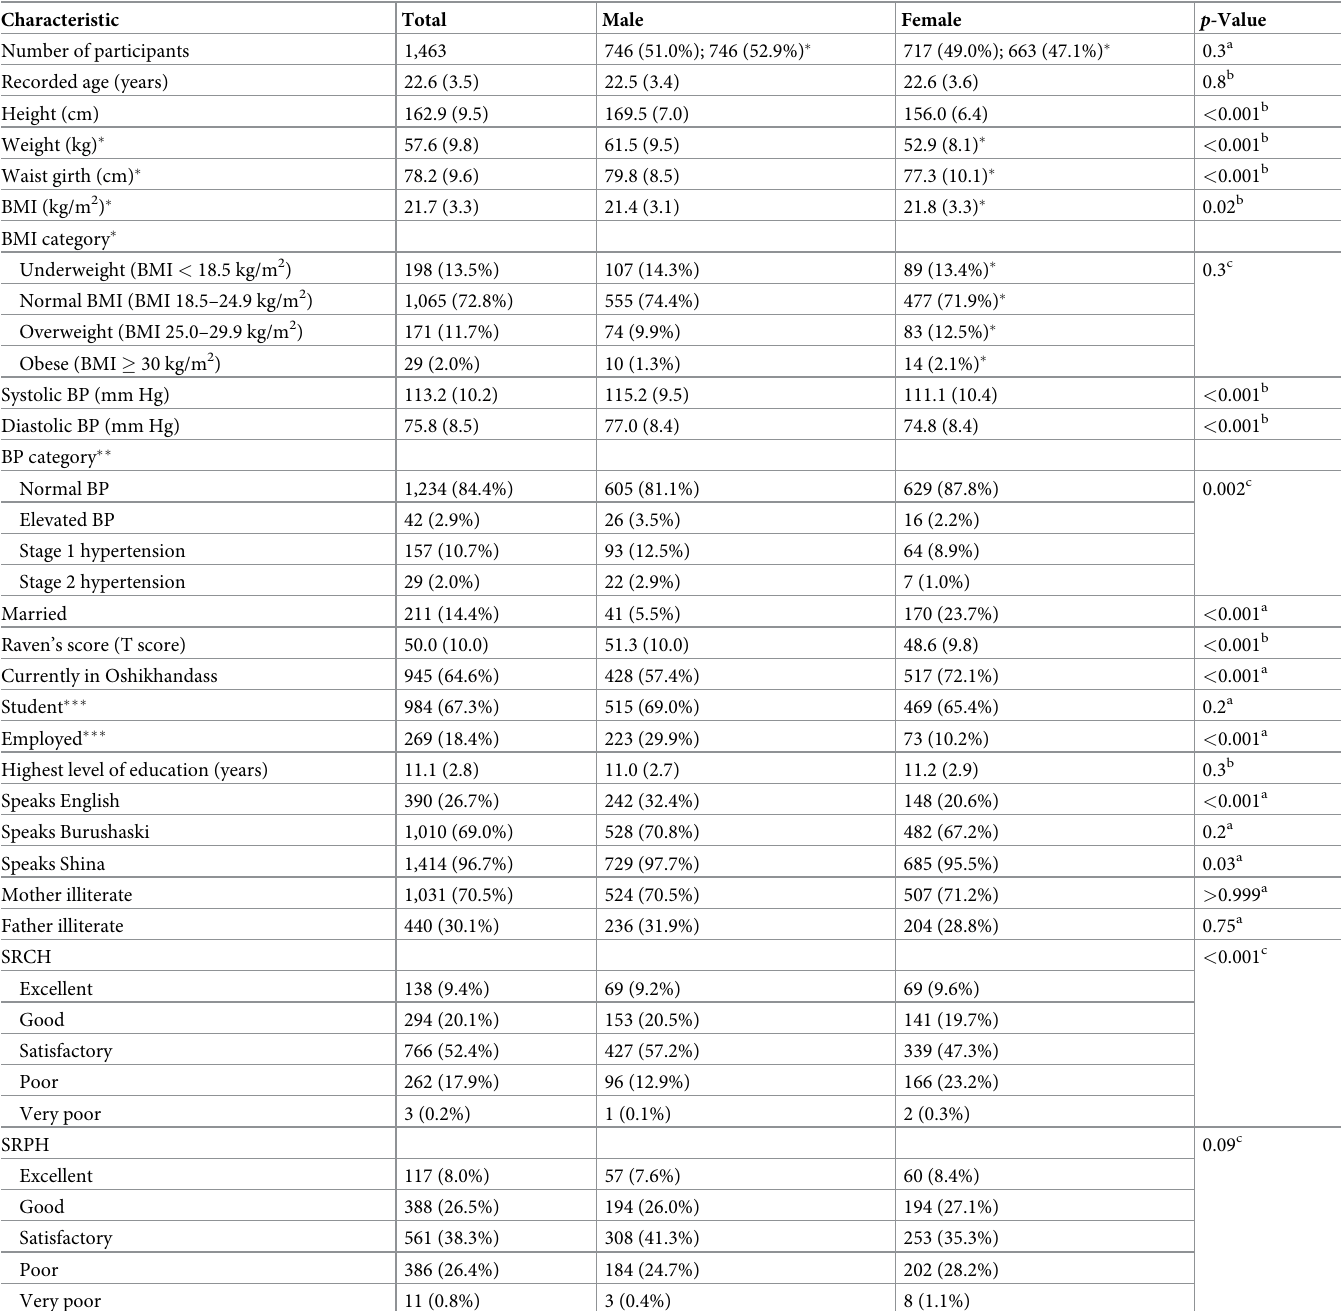
Table 1. Selected descriptive characteristics of the adolescent